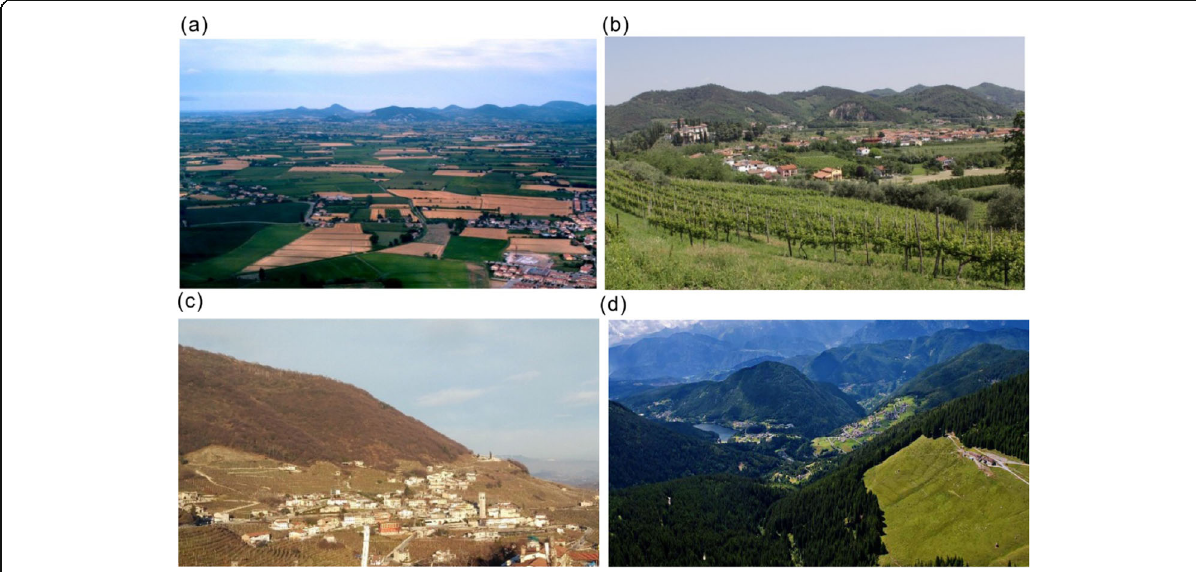
Fig. 2 The field overview of the study areas: a floodplain, b plain to hilly, c hilly, d mountain (photo in 2a by P. Claudio; photo in 2b by M. Luca; photo in 2c by B. Eros, photo in 2d from